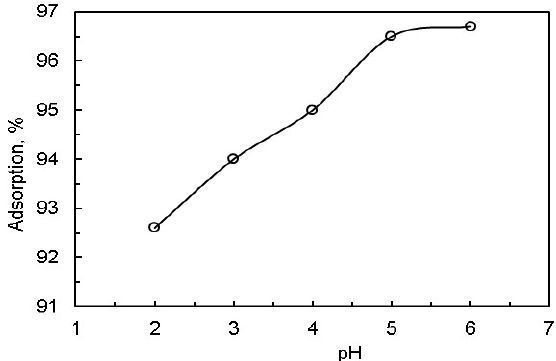
Fig.4. Effect of initial pH of solution on dye adsorption